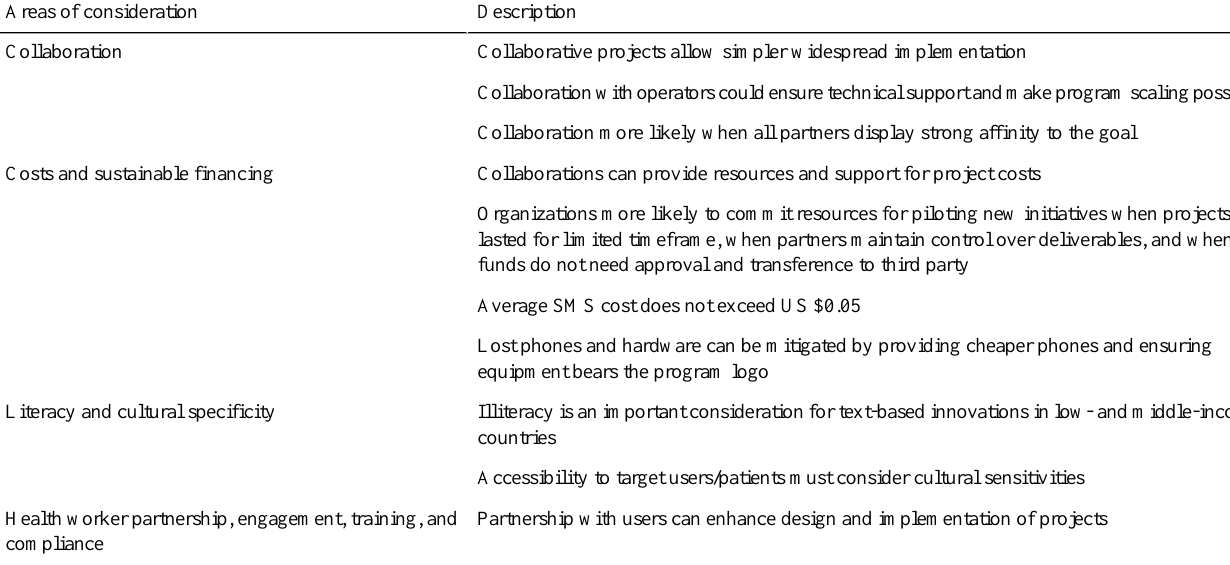
Table 4. Key considerations for successful use and expansion of mHealth